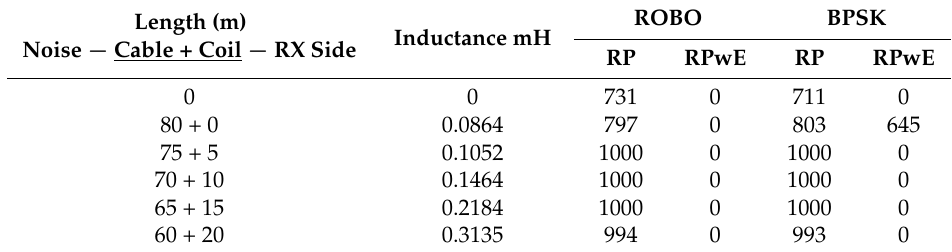
Table 12. ROBO and BPSK Modulations: Coils between the receiving modem and the noise source. Length